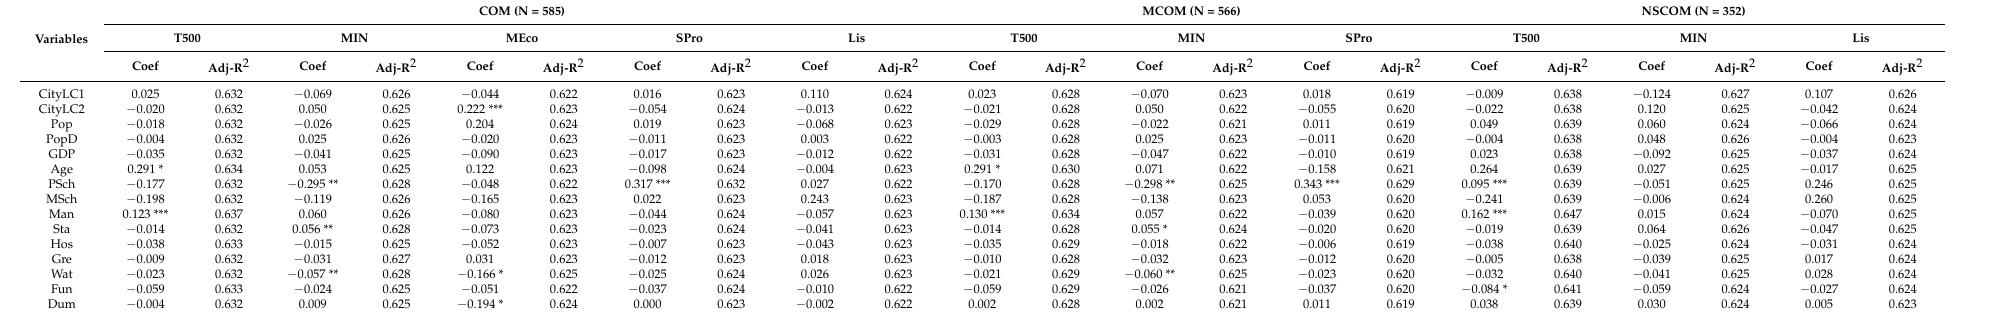
Table 7. Interactive regression results of the developer types (N = 585).